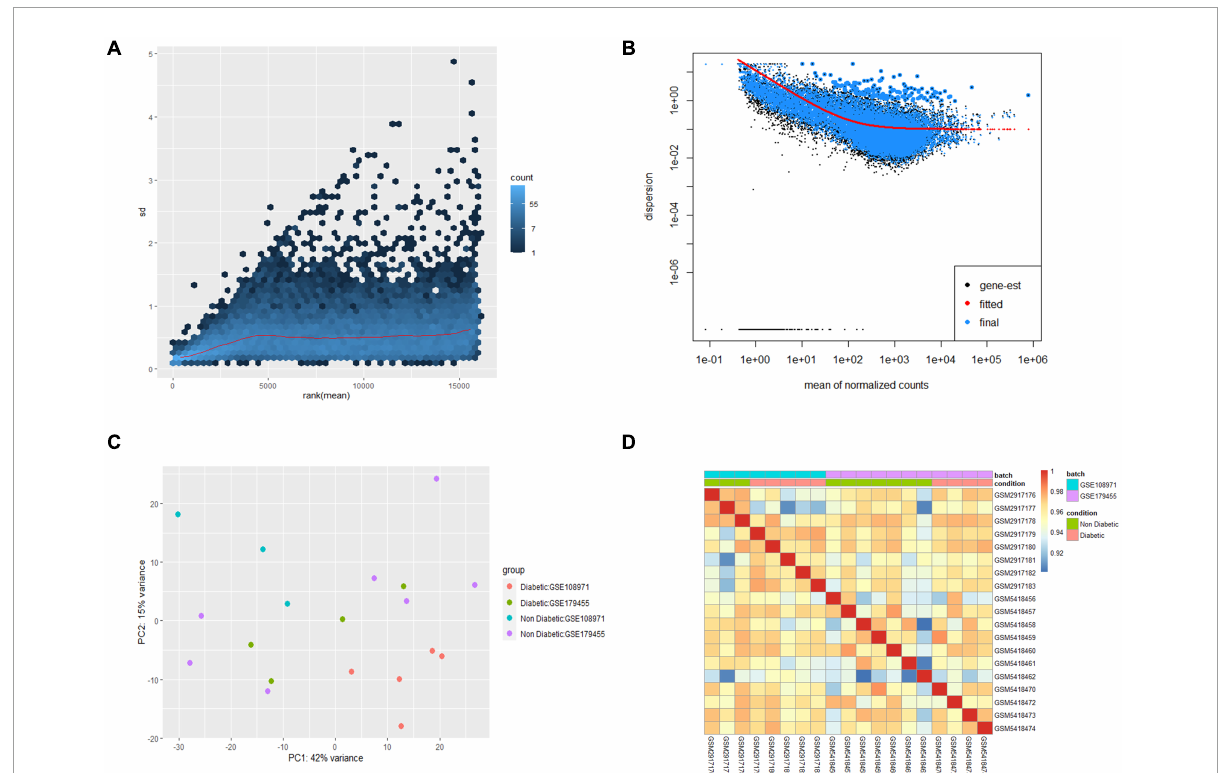
FIGURE1 Preprocessing of the two datasets. (A) Effects of transformation on the variance. (B) Dispersion plot. (C) PCA plot after batch corrected. (D) Cluster dendrogram of 19